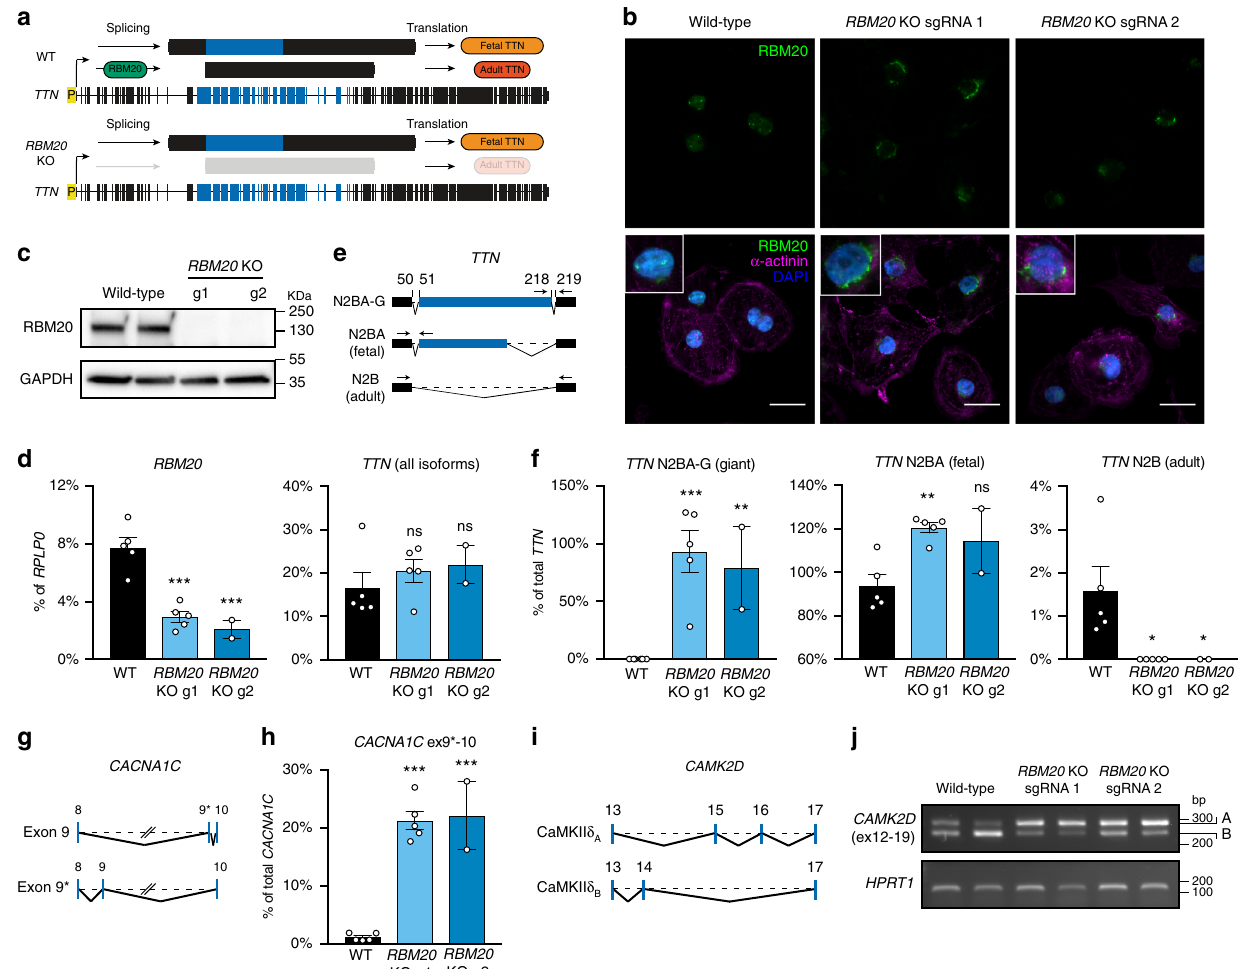
Fig. 9 Knockout of RBM20 dysregulates alternative splicing in hESC-derived cardiomyocytes. a Predicted effects of the knockout of RBM20 on TTN biogenesis (loss of RBM20-dependent alternative exon exclusion). Refer to the legend of Fig. 8a for the abbreviations. b Representative immuno fl uorescence results in CM derived from wild-type or RBM20 knockout hESCs generated with two independent CRISPR/Cas9 single guide RNAs (sgRNAs). Nuclei are counterstained with DAPI, and insets show magni fi ed views; scale bars: 10 µ m. c Western blot validation of RBM20 knockout (uncropped images shown in Supplementary Fig. 11). g: sgRNA. d RT-qPCR in CM derived from the indicated hESC lines. Expression is relative to the housekeeping gene RPLP0 and mean ± s.e.m. is shown. n = 5 (WT and RBM20 KO g1) or 2 ( RBM20 KO g2) independent differentiations. e Expected major TTN isoforms in CM. Exons predicted to be excluded by RBM20 are in blue, and arrows indicate the location of RT-qPCR primers. f As in panel ( d ), but expression of the indicated TTN isoform is relative to the total amount of TTN . g Expected CACNA1C isoforms due to RBM20-dependent alternative exon selection. RBM20 is predicted to favor inclusion of exon 9 over exon 9*. h As in panel ( d ), but expression of the CACNA1C exon 9* isoform is relative to the total amount of CACNA1C . i Expected CAMK2D isoforms due to RBM20-dependent alternative exon selection. RBM20 is predicted to favor inclusion of exon 14 over exons 15 – 16. j Semiquantiative RT-PCR in CM for the indicated CAMK2D isoforms and the housekeeping gene HPRT1 ; n = 2 independent differentiations. All p -values in this fi gure are vs WT and calculated by one-way ANOVA followed by Holm-Sidak ’ s multiple comparisons (ns ≥ 0.05; * < 0.05; ** < 0.01; *** < 0.001). Source data are provided as a Source Data fi